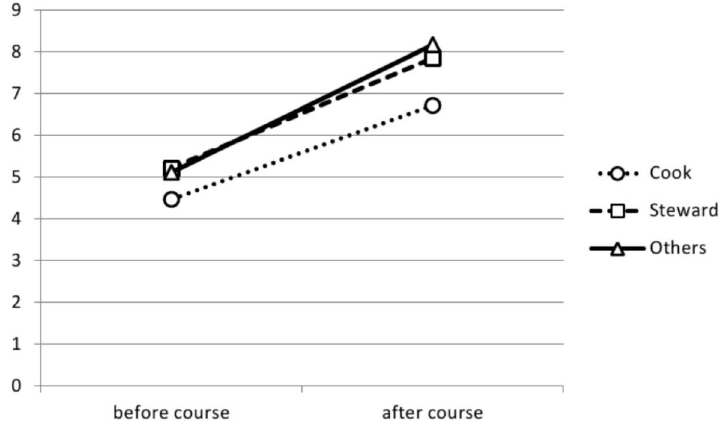
Figure 2a. Mean values of the test assessing level of knowledge of nutritional standards before and after the course, broken down according